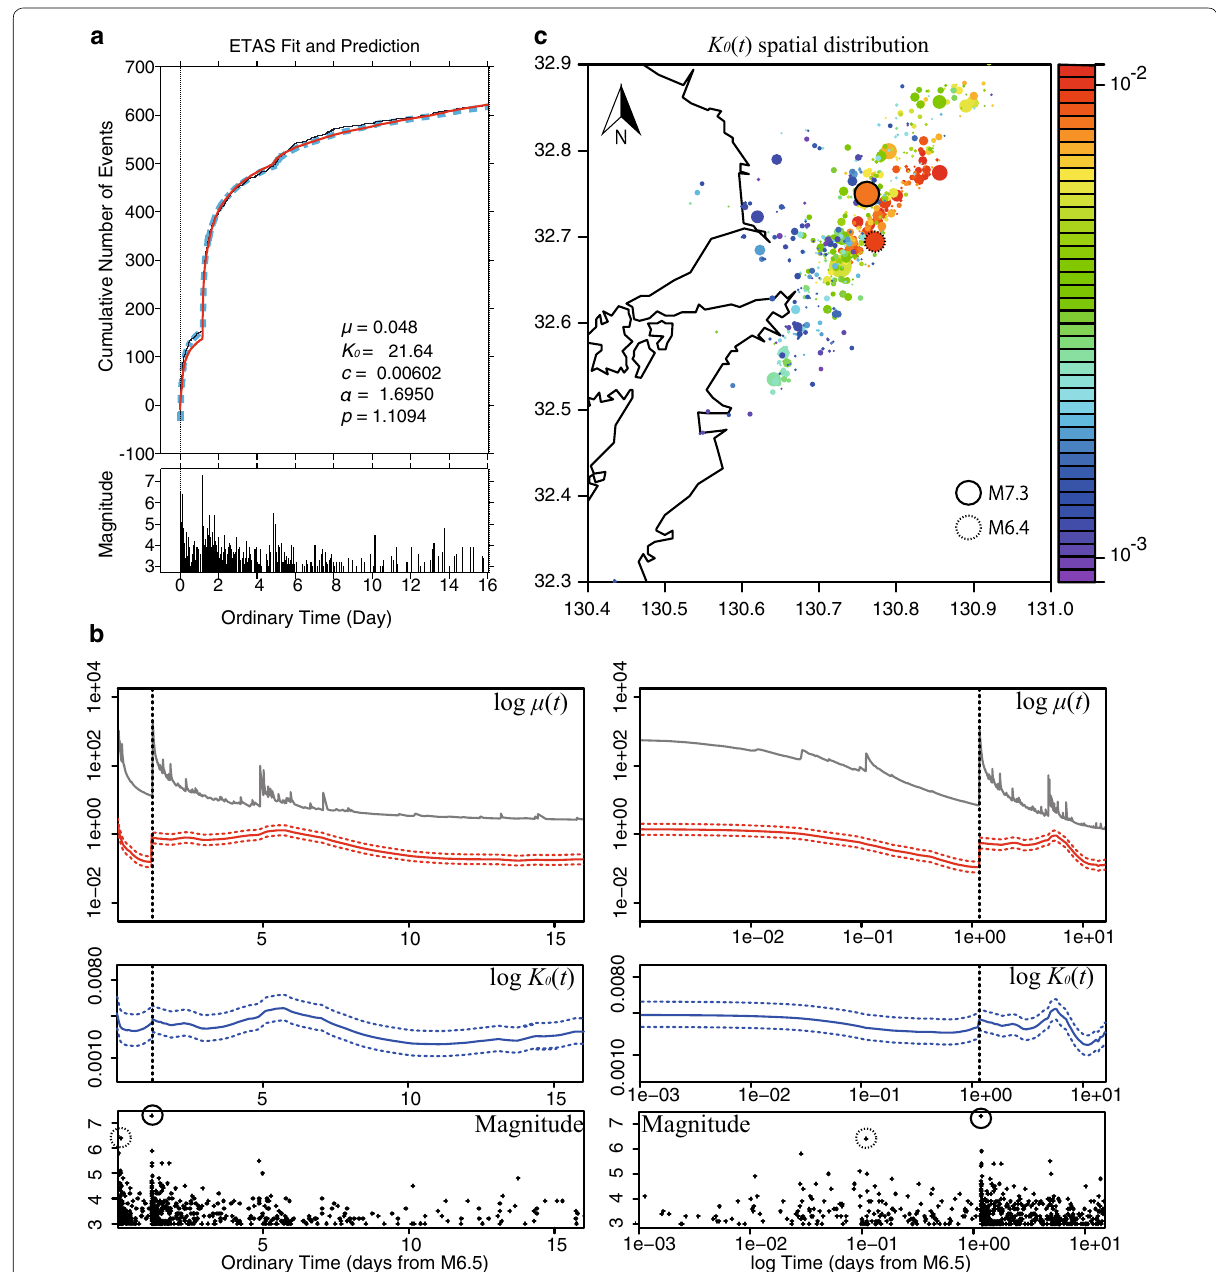
Fig. 7 Non-stationary ETAS model applied to the Kumamoto region (S1 in Fig. 6a). a The red cumulative curve indicates the ETAS model fitted for the entire period. The thick dotted light blue curve indicates the estimated non-stationary ETAS model. b The estimated time-dependent param- eters of the non-stationary ETAS model, where the reference parameters are the MLE of the ETAS model. The MLEs are printed in ( a ). The time axes are on an ordinary scale (left side panel) and a logarithmic scale (right side panel). The vertical dashed line indicates the occurrence time of the M7.3 mainshock. In the M–T plots, the M6.4 and M7.3 events are marked by circles. c The estimates of the K 0 parameters versus the corresponding loca- tions of the aftershocks, where the color table shows the expected number of triggering offspring events of